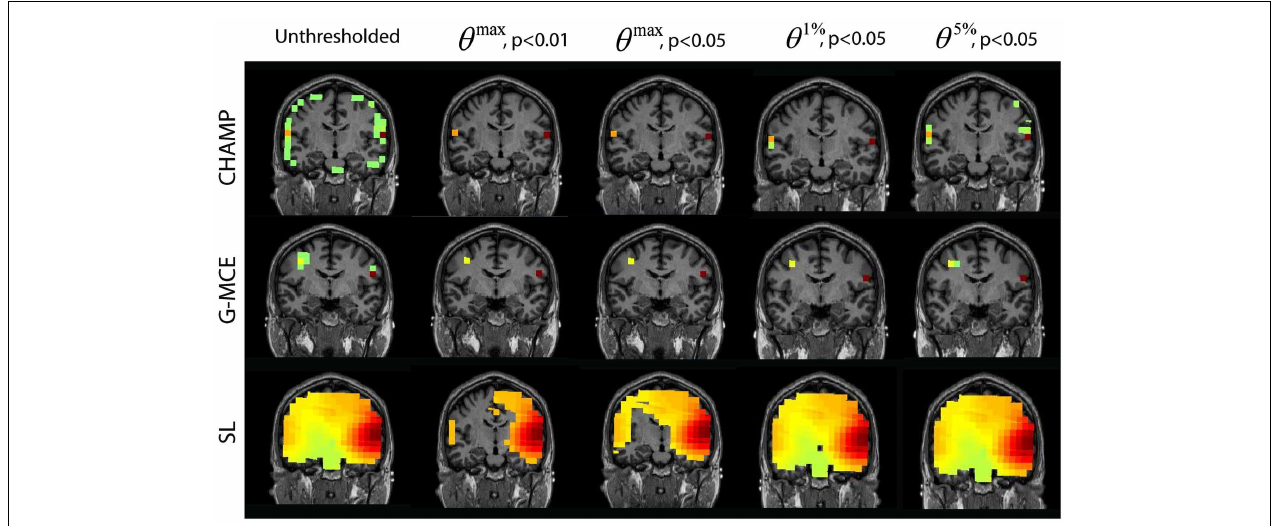
thresholded with the maximal statistic: 0 max , p < 0.01 and 0.05 and with the alternative to the maximal statistic thresholds: θ 1% , p < 0.05, and θ 5% , p <